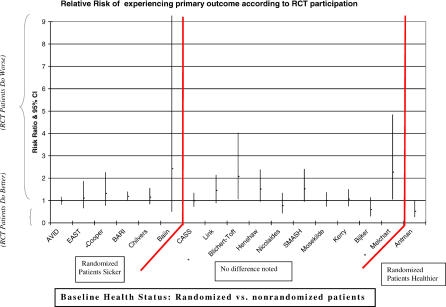
Relative Risk of Experiencing Primary Outcome According to RCT ParticipationAsterisks indicate statistical significance. The relevant references for the studies listed along the
x-axis are as follows: AVID [
50,
68], EAST [
51], Cooper [
52], BARI [
24], Chilvers [
53], Bain [
54], CASS [
55], Link [
57], Blichert-Toft [
30], Henshaw [
58], Nicolaides [
59], SMASH [
63], Mosekilde [
64], Kerry [
67], Bijker [
25], Melchart [
29], and Antman [
31].